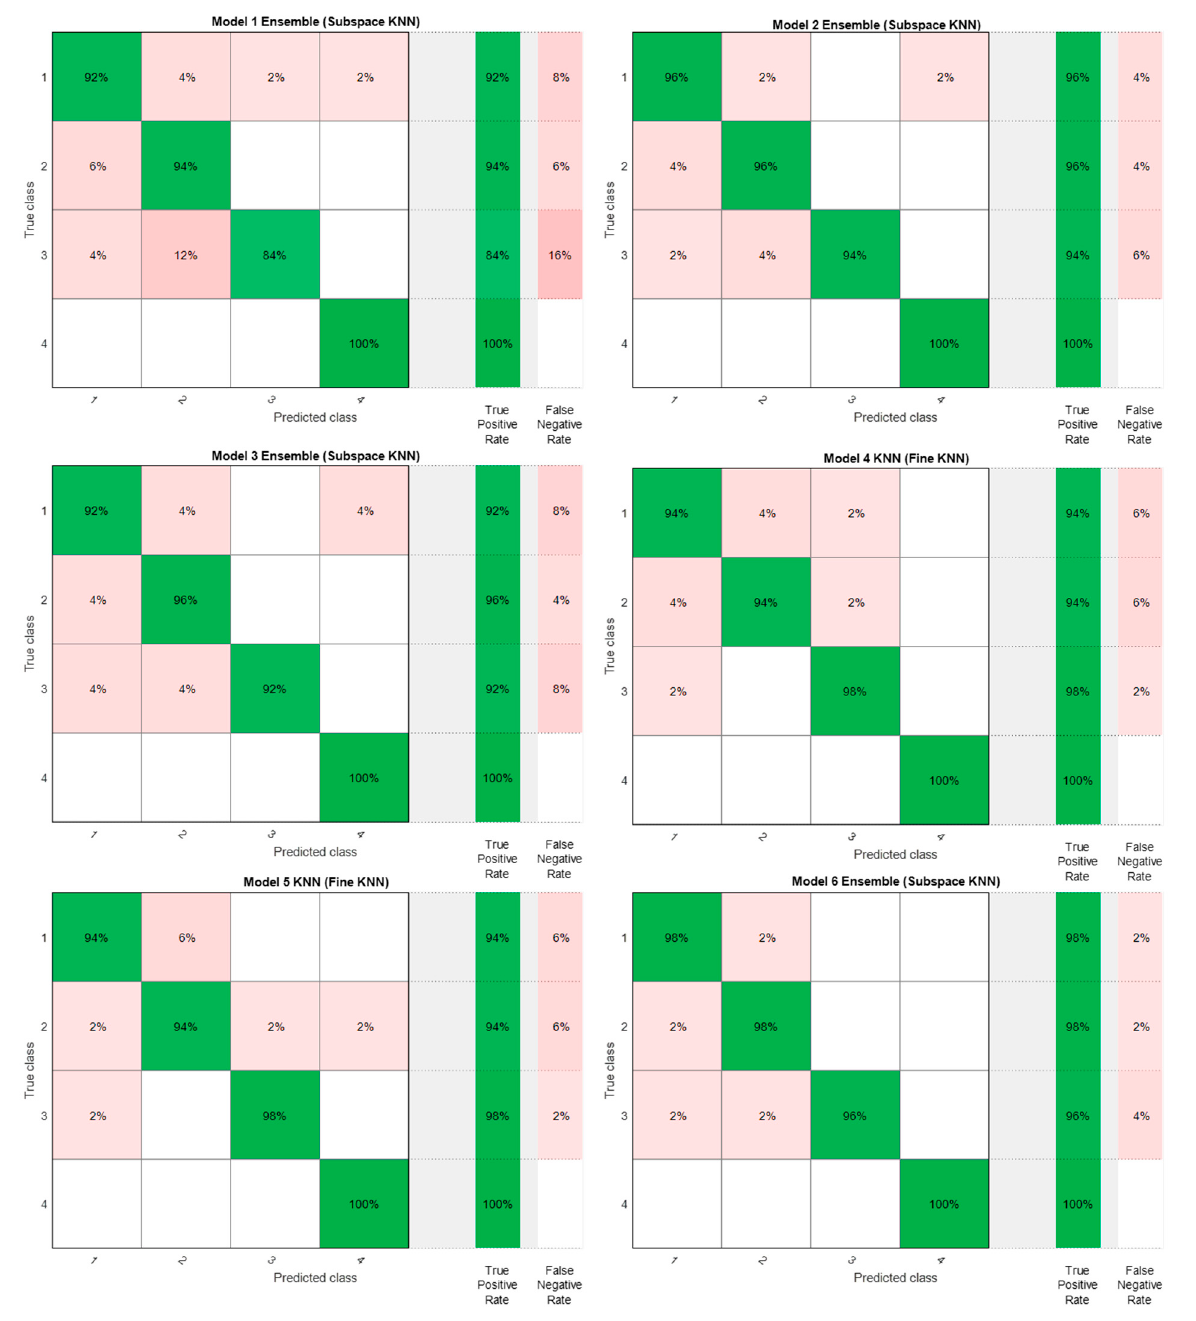
Figure 3. Confusion matrix of six scenario models.